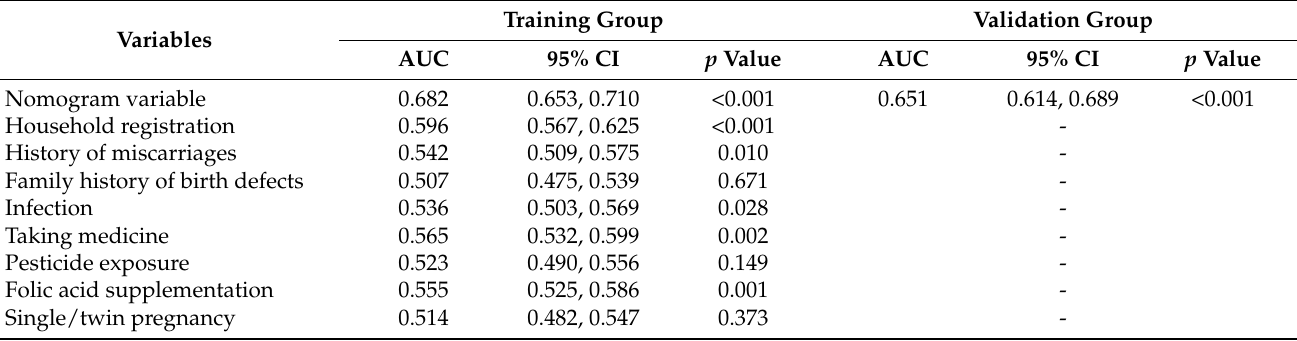
Table 4. The AUCs of the ROC curves for the nomogram and variables from the logistic regression model in the training group and validation group.